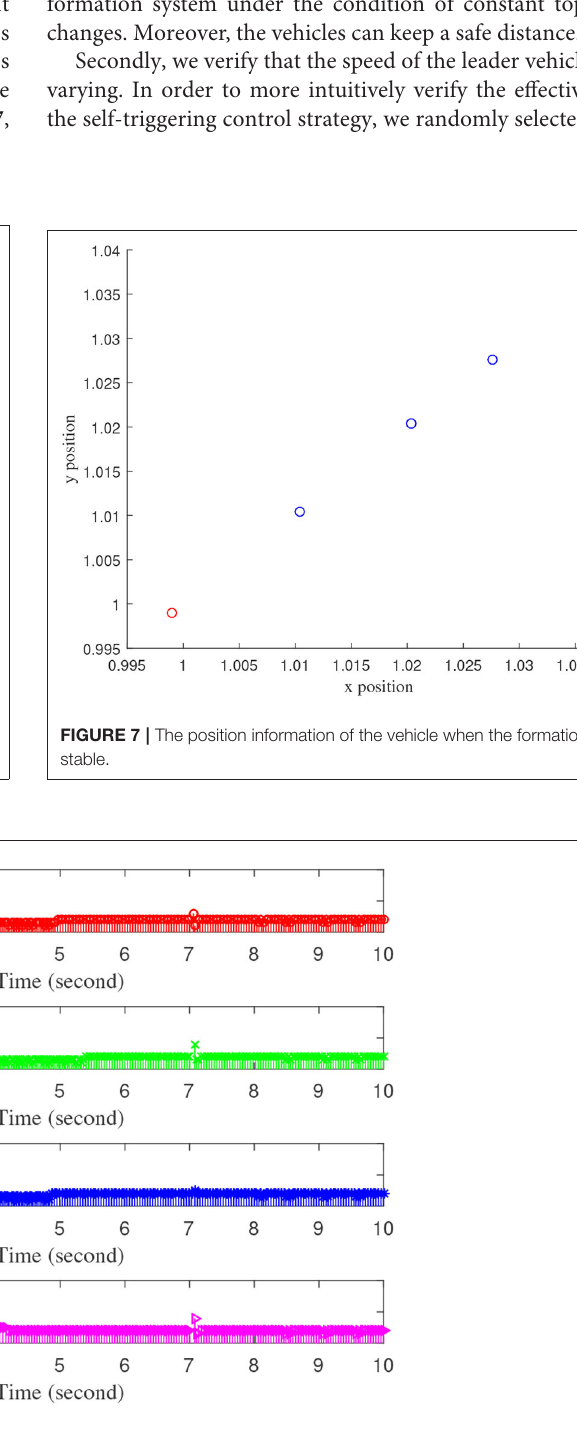
FIGURE 6 | The event trigger interval of each follower